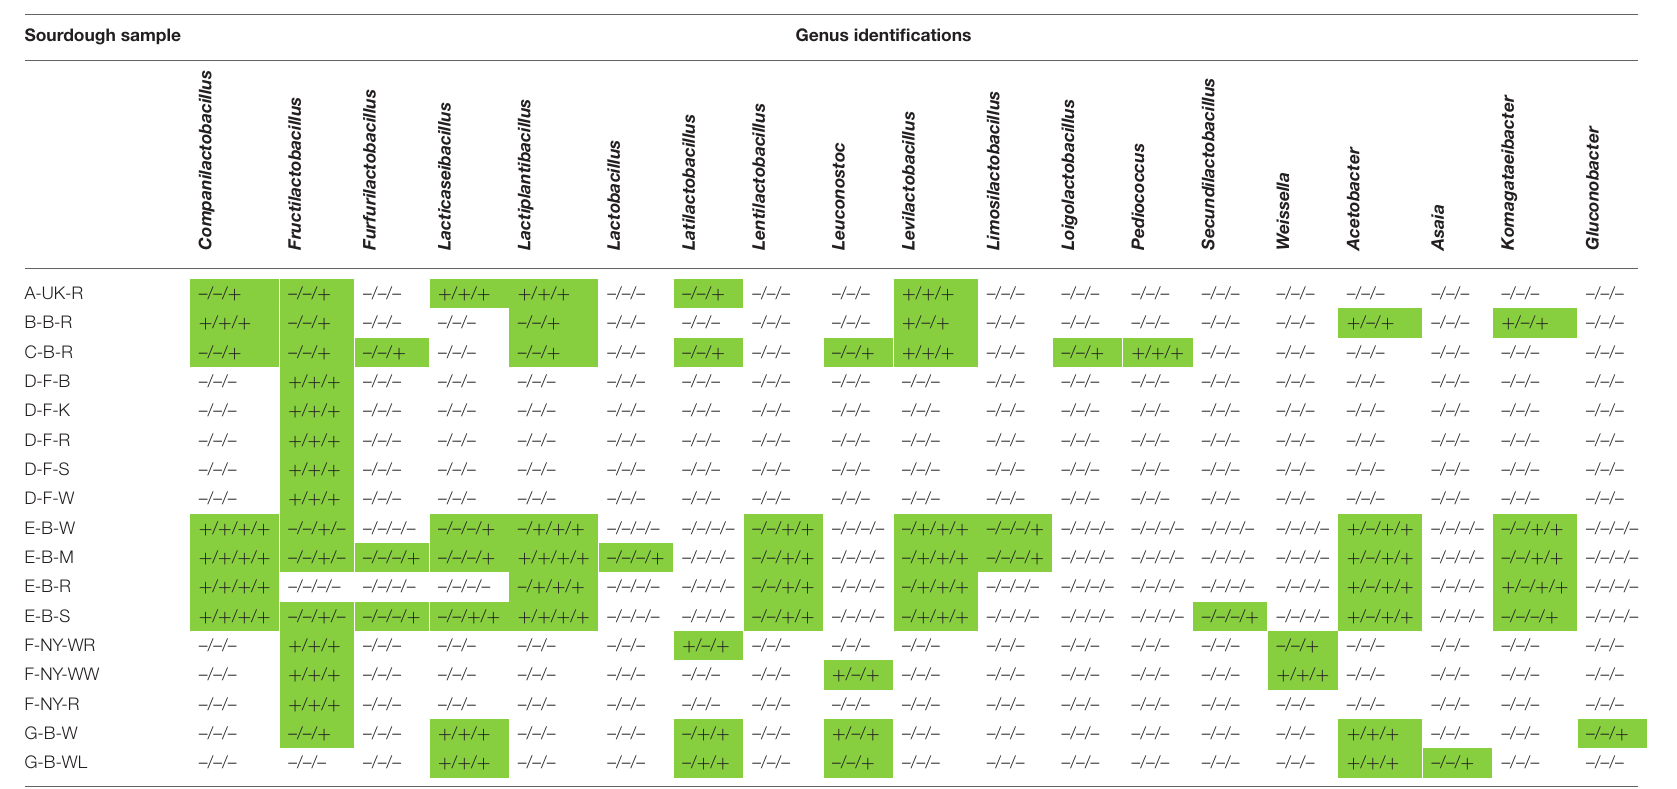
TABLE 4 | Comparison of the culture-dependent and culture-independent identifications of lactic acid bacterial and acetic acid bacterial genera in 17 sourdough samples from backslopped sourdoughs of different origins, indicated as presence ( + ) or absence (–) through colony identification, rRNA-PCR-DGGE, metagenetics, and metagenomics (only producer E),